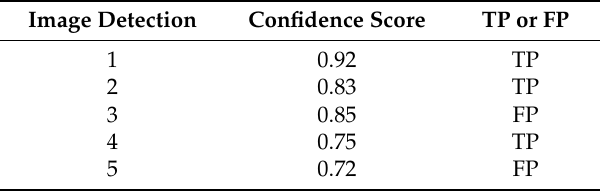
Table 2. Example detection results of one category.